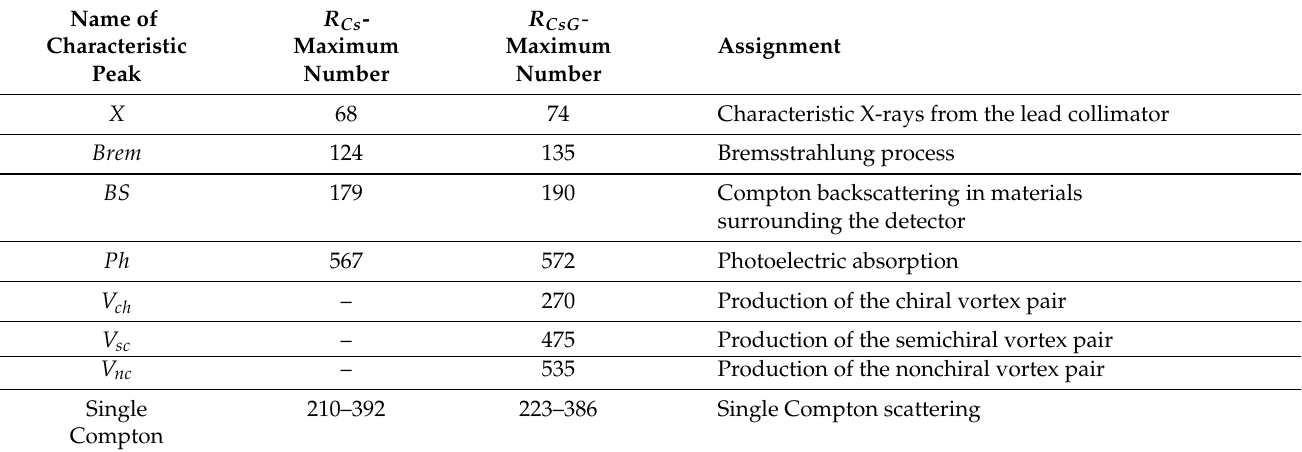
Table 1. Maximal channel numbers for the characteristic peaks “ X ”, “ Brem ”, “ BS ”, “ Ph ”, “ V i ”, i = ch , sc , nc and the region of the single Compton continuum in the response functions, R Cs and R CsG , recorded without and with the CNT bilayer,